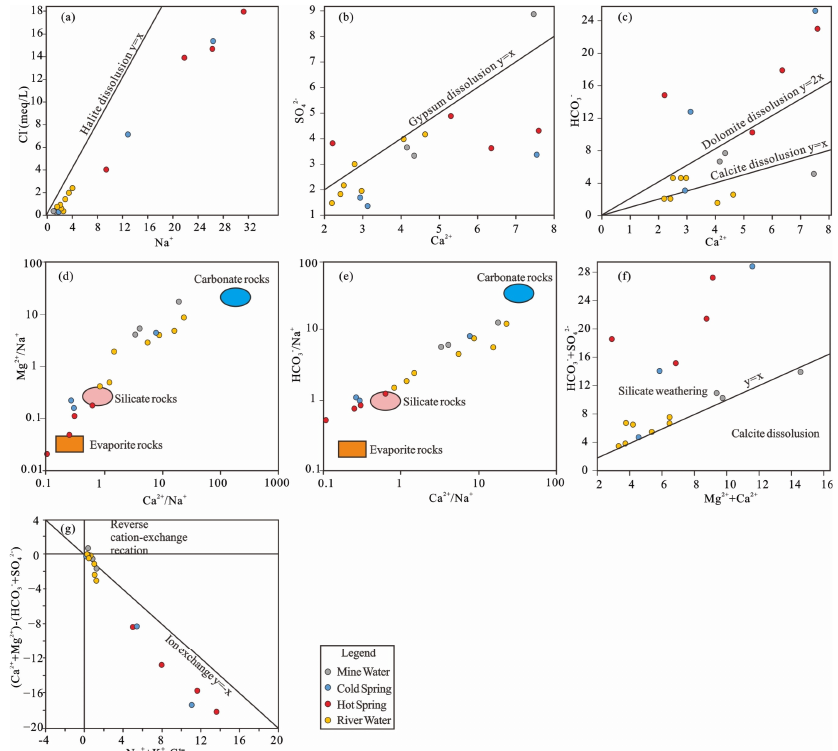
Figure 8. Relationship diagrams of ( a ) Cl − vs. Na + , ( b ) SO 42 − vs. Ca 2+ , ( c ) HCO 3 − vs. Ca 2+ , ( d ) (Mg 2+ /Na + ) vs. (Ca 2+ /Na + ), ( e ) (HCO 3 − /Na + ) vs. (Ca 2+ /Na + ), ( f ) HCO 3 − + SO 42 − vs. Ca 2+ + Mg 2+ , ( g ) Na + + K + − Cl − vs. Ca 2+ + Mg 2+ − (HCO 3 − + SO 42 − ).